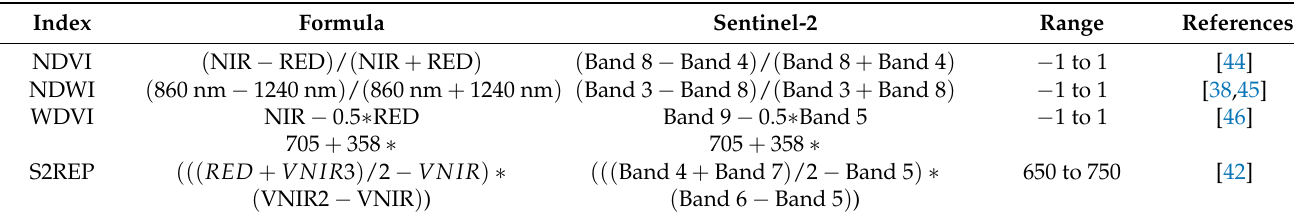
Table 1. Details of Sentinel-2